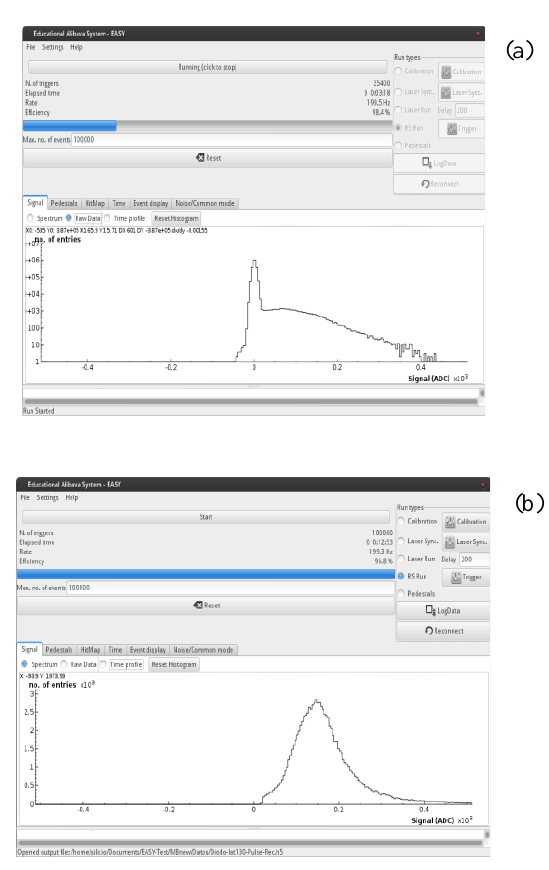
Fig. 4. Charge spectrum, in ADC count, of a Sr-90 source, (a) raw data in logarithmic scales and (b) after data analysis